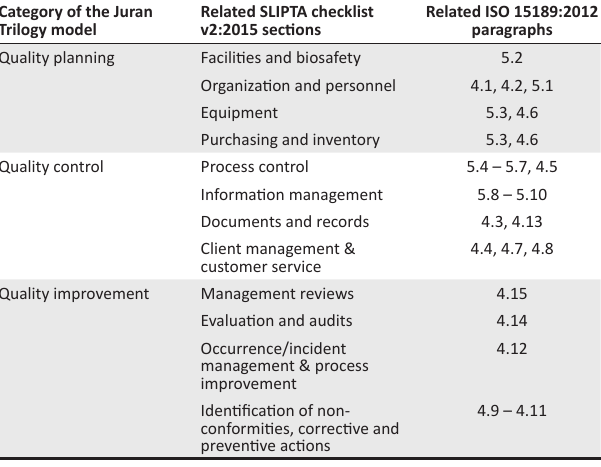
TABLE 2: Distribution of Stepwise Laboratory Quality Improvement Process Towards Accreditation checklist v2:2015 sections over the different categories of the Juran Trilogy.